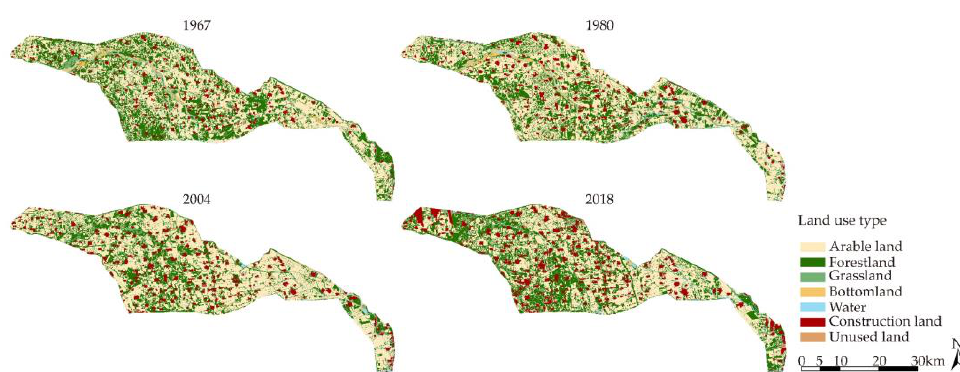
Figure 2. Land use in the Yongding River floodplain from 1967 to 2018.